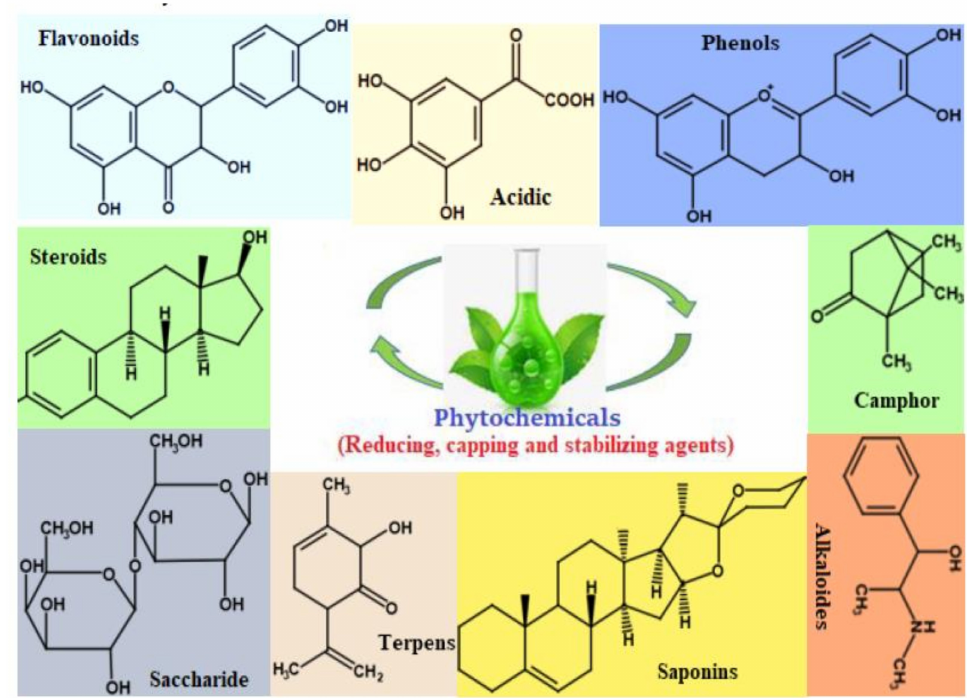
Figure 9. Some of the Phytochemicals present in different parts of plants [67].